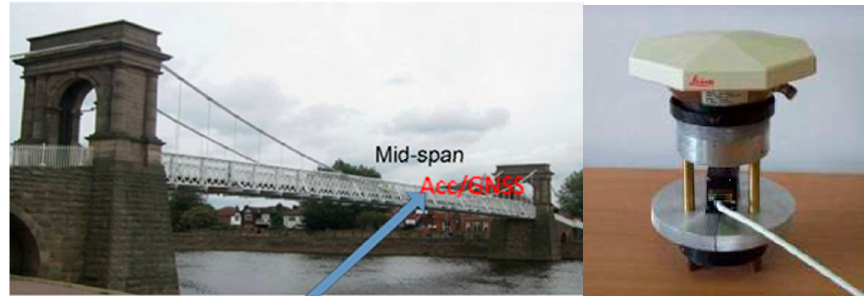
Figure 9. The Wilford Bridge test site with accelerometer setup. Table 2. Incentive bridge deformation events.